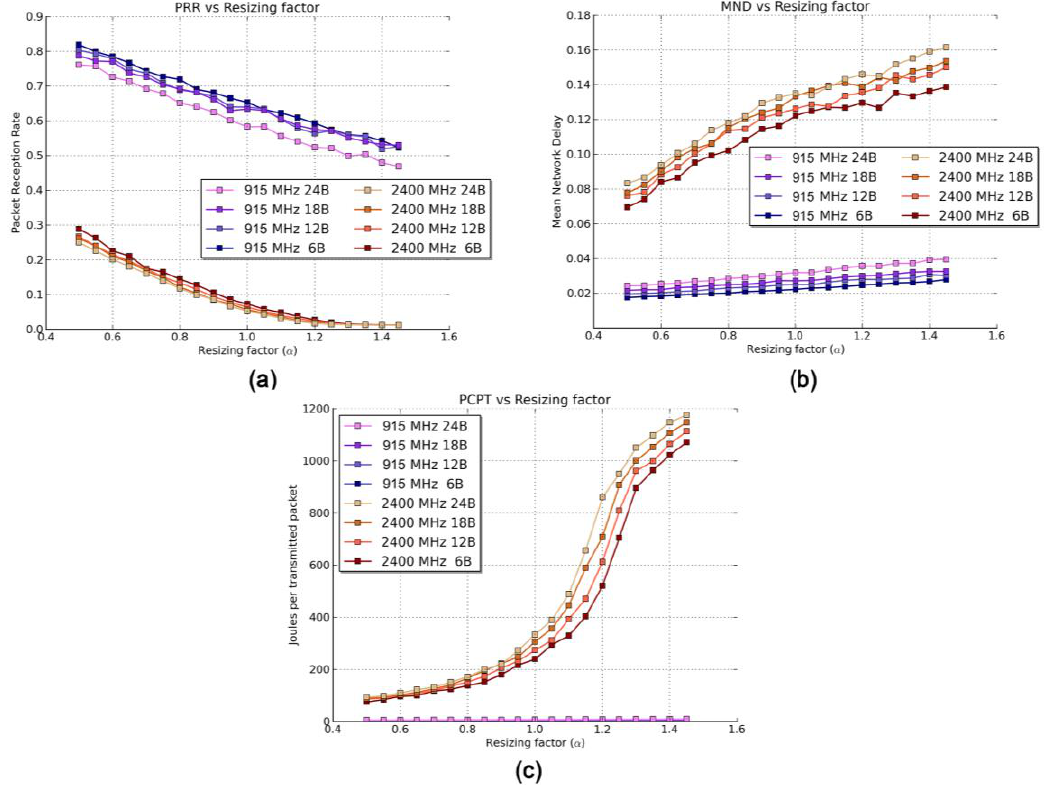
Figure 5. Results of the Scenario 1 for different packet sizes and resizing factors. ( a ) PRR, ( b ) MND, and ( c ) PCPT.